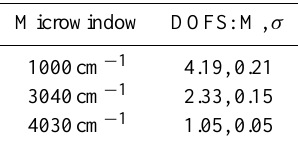
Table 2. Mean ( M ) and standard deviation ( σ ) of the DOFS time series of the retrieved OTC of Izaña IFS 120 / 5HR (2005–2012) for each spectral